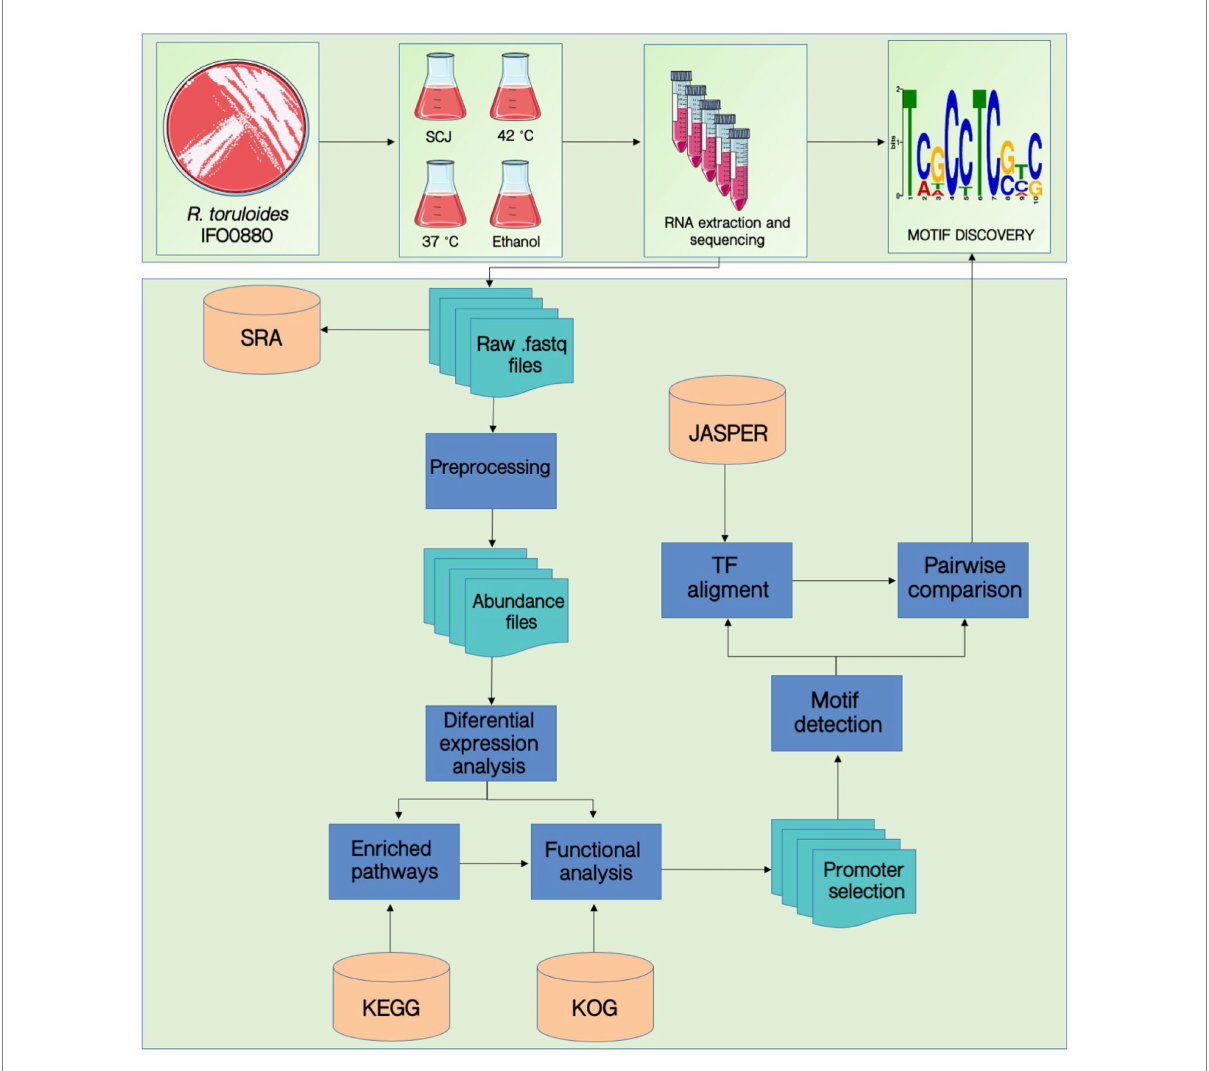
FIGURE 1 Workflow for the discovery of cis -regulatory elements using transcriptomic